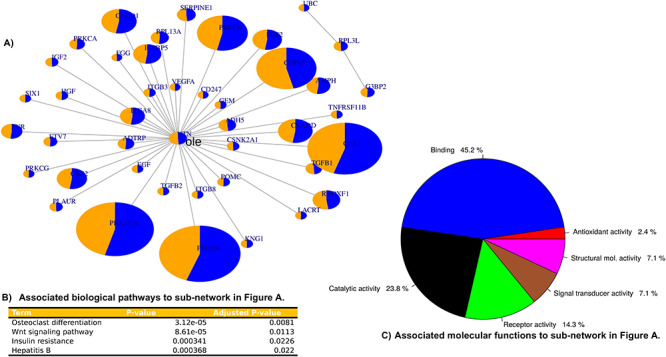
Reconstituted HI PPI network including enrichment analysis of the associated pathways and molecular functions. Figure 2 indicates PPI associated with VTN, RPL3L, FOXD4L6 and DHRS4L2 as well as the associated pathways and molecular functions. The protein products of VTN and RPL3L are associated with 42 pairings/interactions. FOXD4L6 and DHRS4L2 have no interactions with other HI-associated proteins, as indicated in (A). The interactions were queried in the Enrichr database that indicated the major pathways associated, which includes osteoclast differentiation, as indicated in (B). (C) The associated molecular function, which includes binding and catalytic activities.